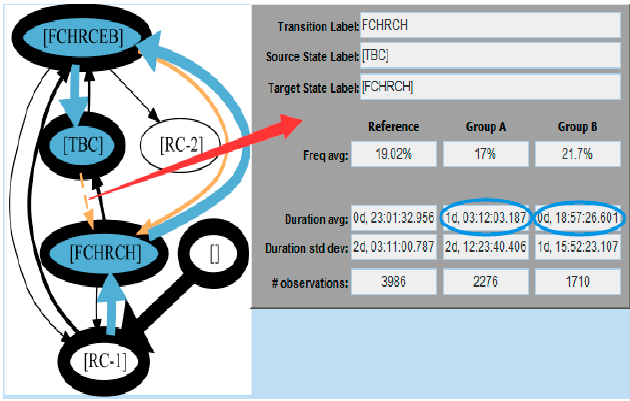
Figure 12. Process comparison of CHS cases with different complaint causes.